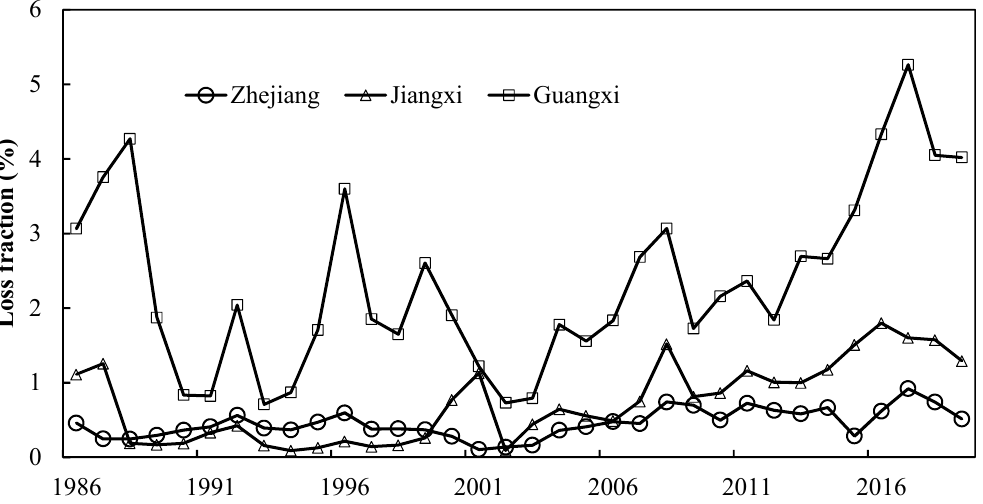
Figure 6. Interannual variations in detected forest loss fraction (%) relative to forest area in 1986 in Zhejiang, Jiangxi, and Guangxi Province during 1986–2019.